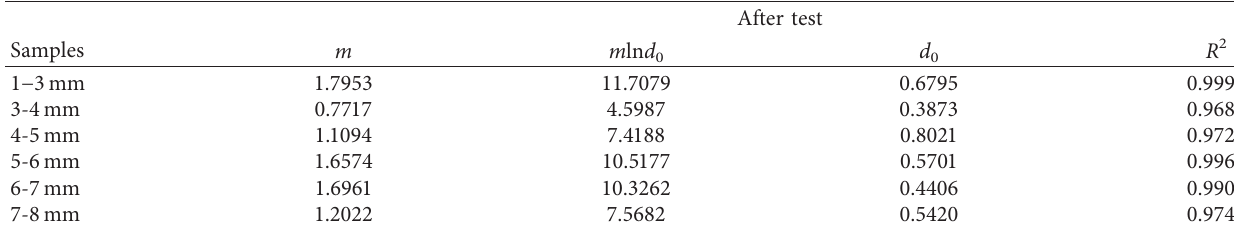
Table 4: Fitting parameters of Rosin–Rammler